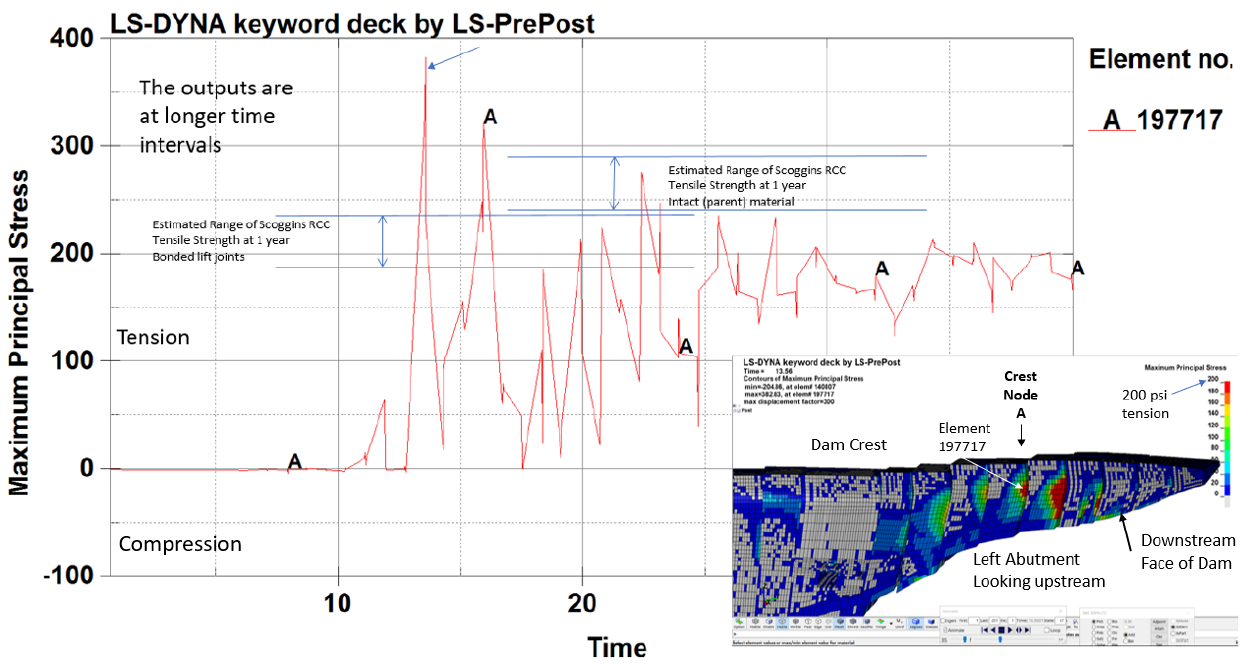
Figure 10. Plot of maximum stress response in vicinity of Crest Node A during the 5000-year, short- duration earthquake. (note stress plot in lower right are tensile in psi units. 145 psi = 1 MPa). The principal stresses shown on the vertical axis are in psi. Positive numbers represent tension and neg- ative numbers represent compression.